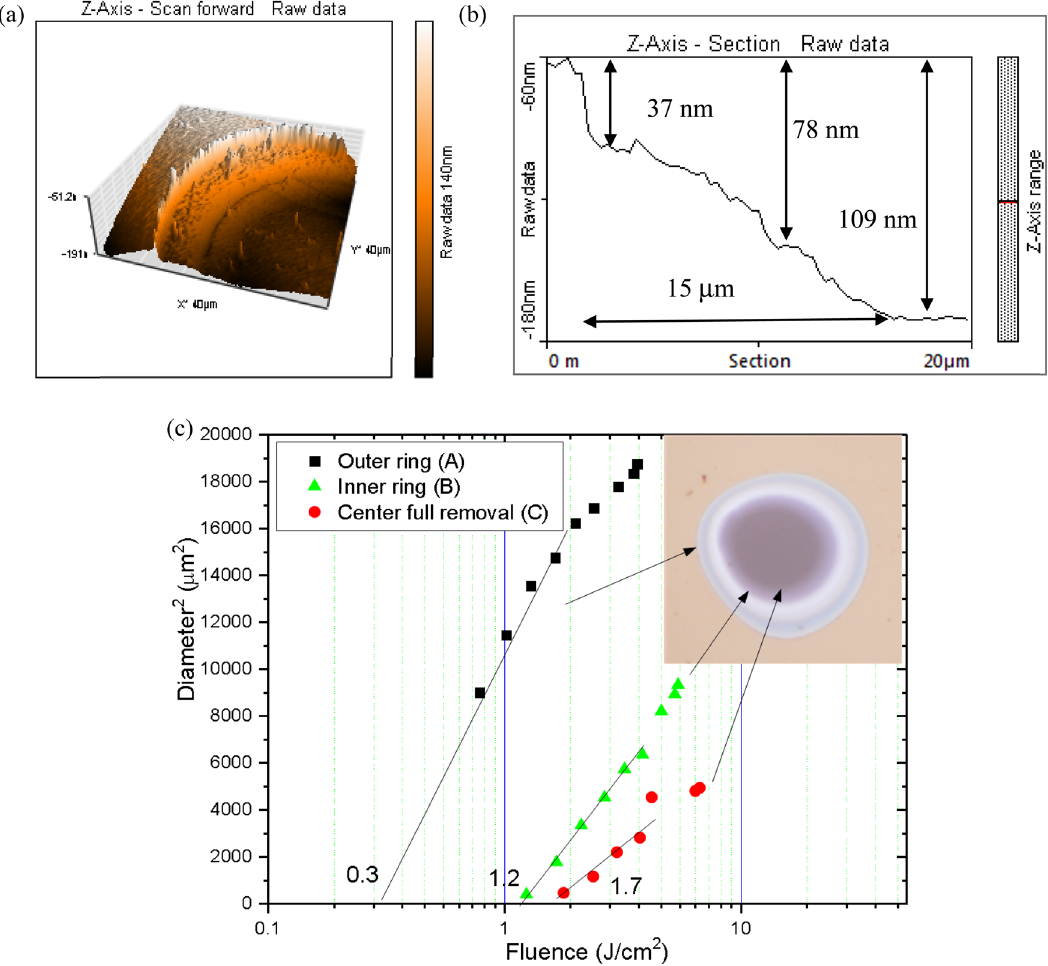
Figure 11: ( a ) The 3D contour of the ablation area obtained by AFM. ( b ) The cross section of the ablated spot. ( c ) The threshold fl uence for 3 types of modi fi cations by fs laser pulse on ITO/glass are determined from the diameter square versus fl uence plot. Table 1: Threshold fl uence for ns laser interaction with ITO/PET and ITO/glass 266 nm 6 ns